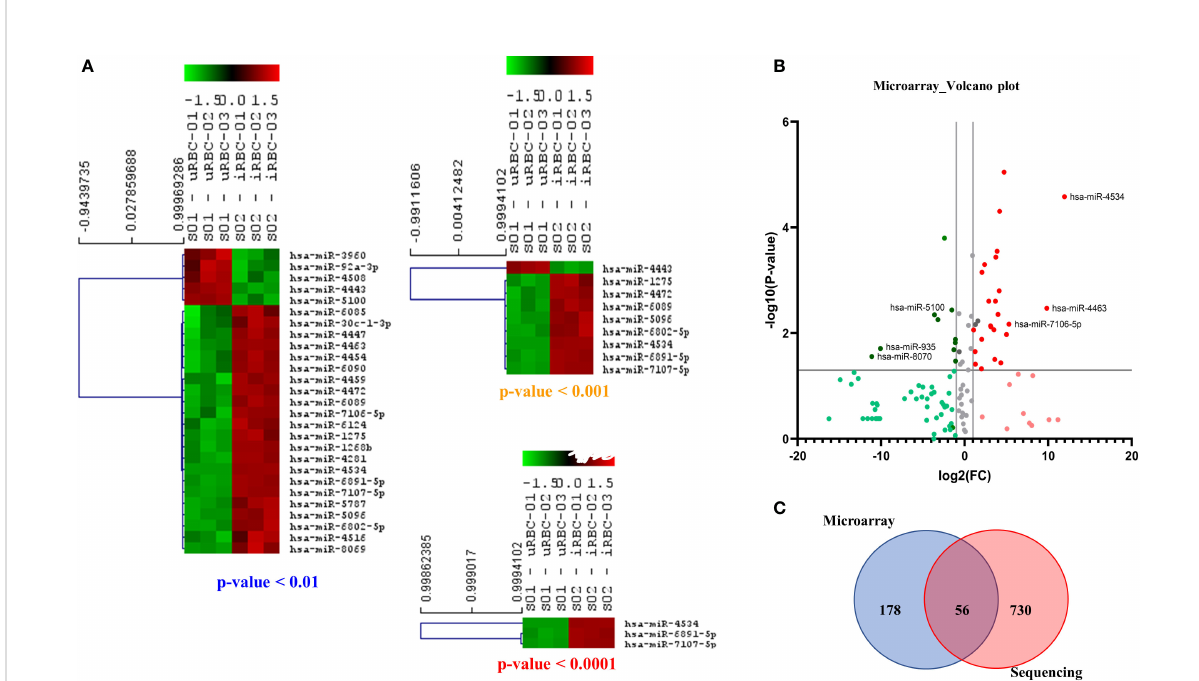
FIGURE 7 Microarray-based analysis of microRNAs (miRNAs) from extracellular vesicles (EVs) derived from uninfected RBCs (uRBCs) and B. divergens – infected RBCs (iRBCs). (A) Heat map shows the miRNAs that were changed at different p -value cutoffs (<0.01, <0.001, and <0.0001) between EVs from uRBCs and iRBCs (n = 3). As shown, these miRNAs were differentially expressed between the two sample sets. (B) Volcano plot representing the fold change (FC) and p-value of miRNAs differentially expressed in EVs from iRBCs with respect to those from uRBCs. Interpretation of colors is identical to Figure 6D. The top three upregulated and downregulated miRNAs in the analysis have been identi fi ed. (C) Venn diagram showing the overlap between miRNAs detected by microarray versus sequencing using next-generation sequencing. Fifty-six miRNAs were detected in both the platforms, whereas 178 and 730 unique miRNAs were detected by the two platforms,